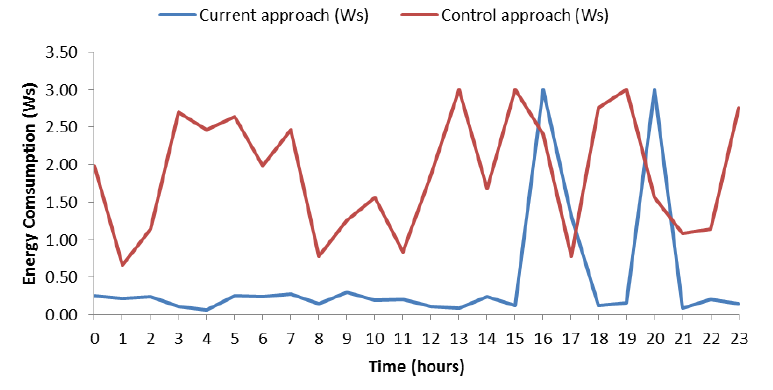
Figure 13. Energy consumption on 13